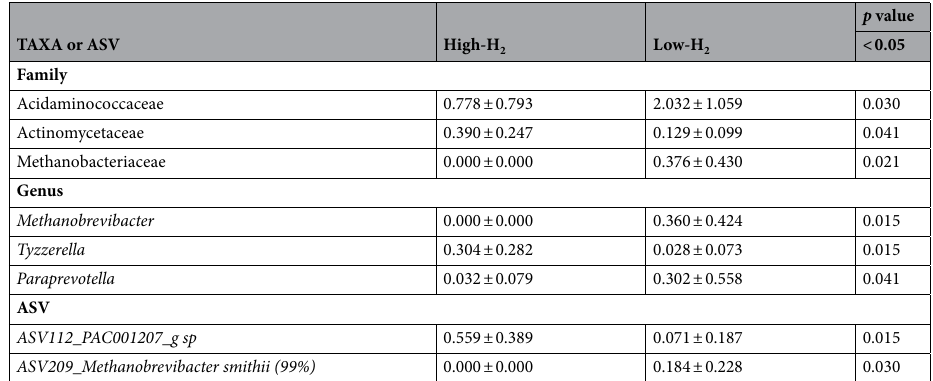
Table 4. Subgroup analysis: gut microbiota composition at baseline (n = 13). Gut microbiota composition differences at baseline between the two subgroups according to lactulose hydrogen breath test responses. Data are expressed as mean percentage of relative abundance and presented as mean ± SD. Wilcoxon–Mann Whitney tests were performed and considered as significant if p < 0.05. For ASV identification, species name is indicated when the identity is >